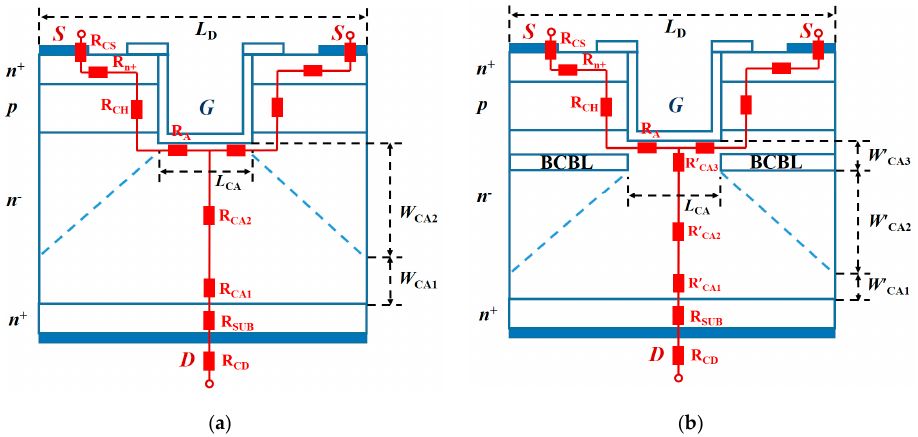
Figure 5. Schematic view of the equivalent circuit for the overall resistances between source and drain terminals in ( a ) the conventional vertical field-effect transistor (VFET) and ( b ) the proposed BCBL-VFET.